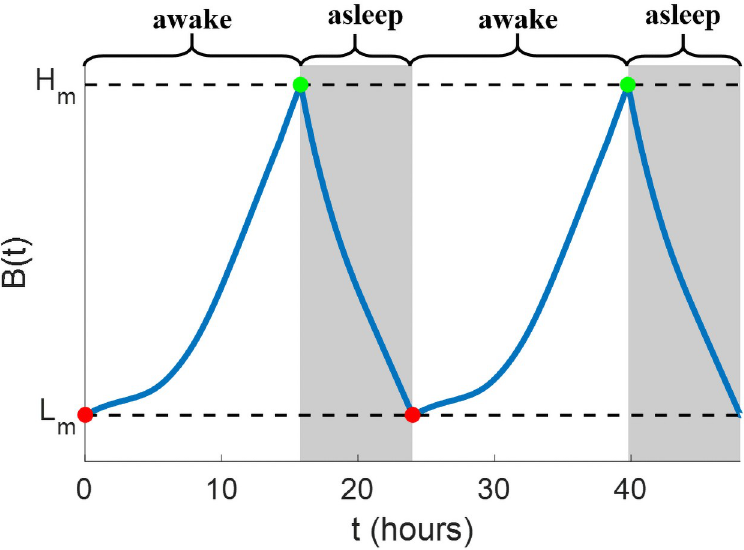
Fig 2. Illustrations of sleep state (gray region) and sleepiness (blue curve) under the spontaneous sleep schedule in Eq (9). The subject wakes up spontaneously when B = L (green